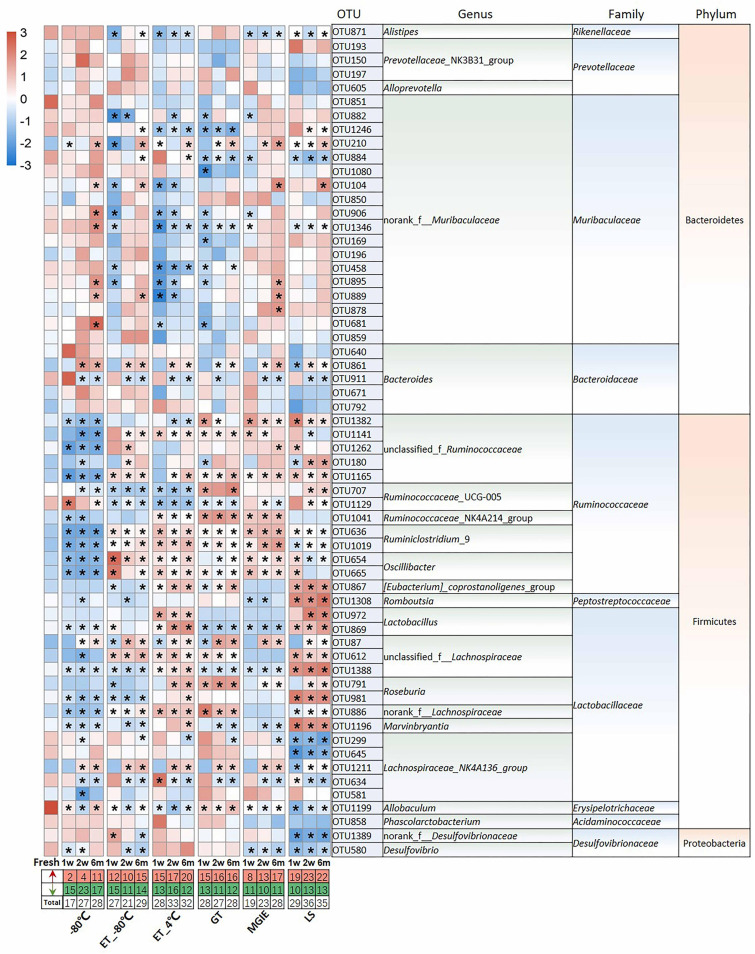
The impact of preservation methods on the top 60 OTUs. Heatmaps shown was the differences in relative abundance among groups of the top 60 OTUs, which accounted for about 65% of coverage, as well as their taxa information including genus, family, and phylum. The red and green entries indicate the number of OTU that were significantly more or less abundant under different storage conditions relative to fresh samples, respectively. n = 5 per group. *p < 0.05 and FDR < 0.05, compared with fresh group.